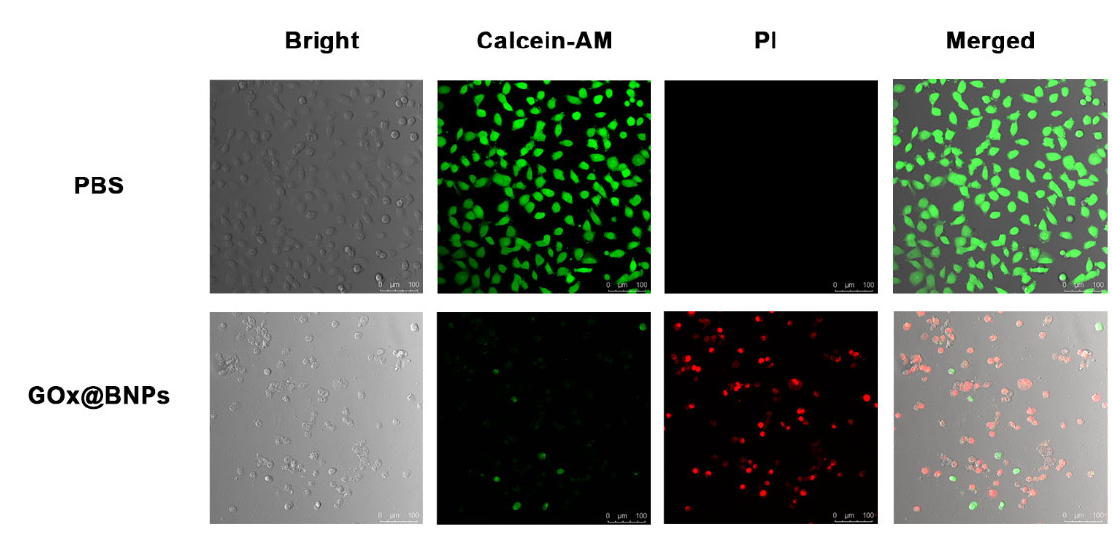
Figure 5. Live/dead A549 cells’ staining after treatment with PBS or GOx@BNPs (10 μ M) at 37 °C for 12 h in the presence of glucose (1 mg/mL). Scale bars: 100 μ m.